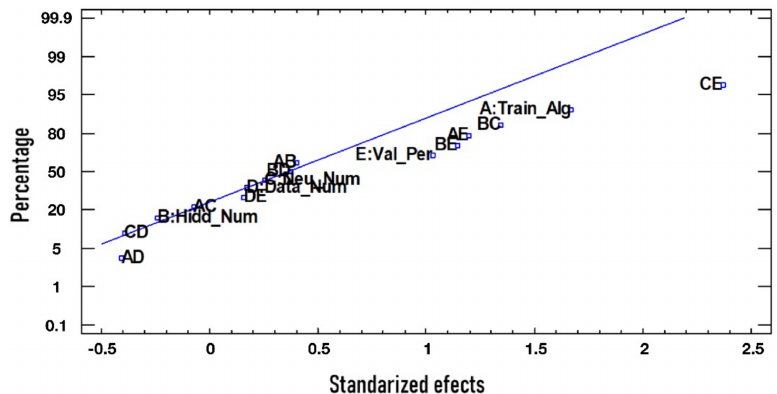
Figure 2. Normal probability plot for Mean Absolute Percentage Error (MAPE). Table 6. ANOVA for